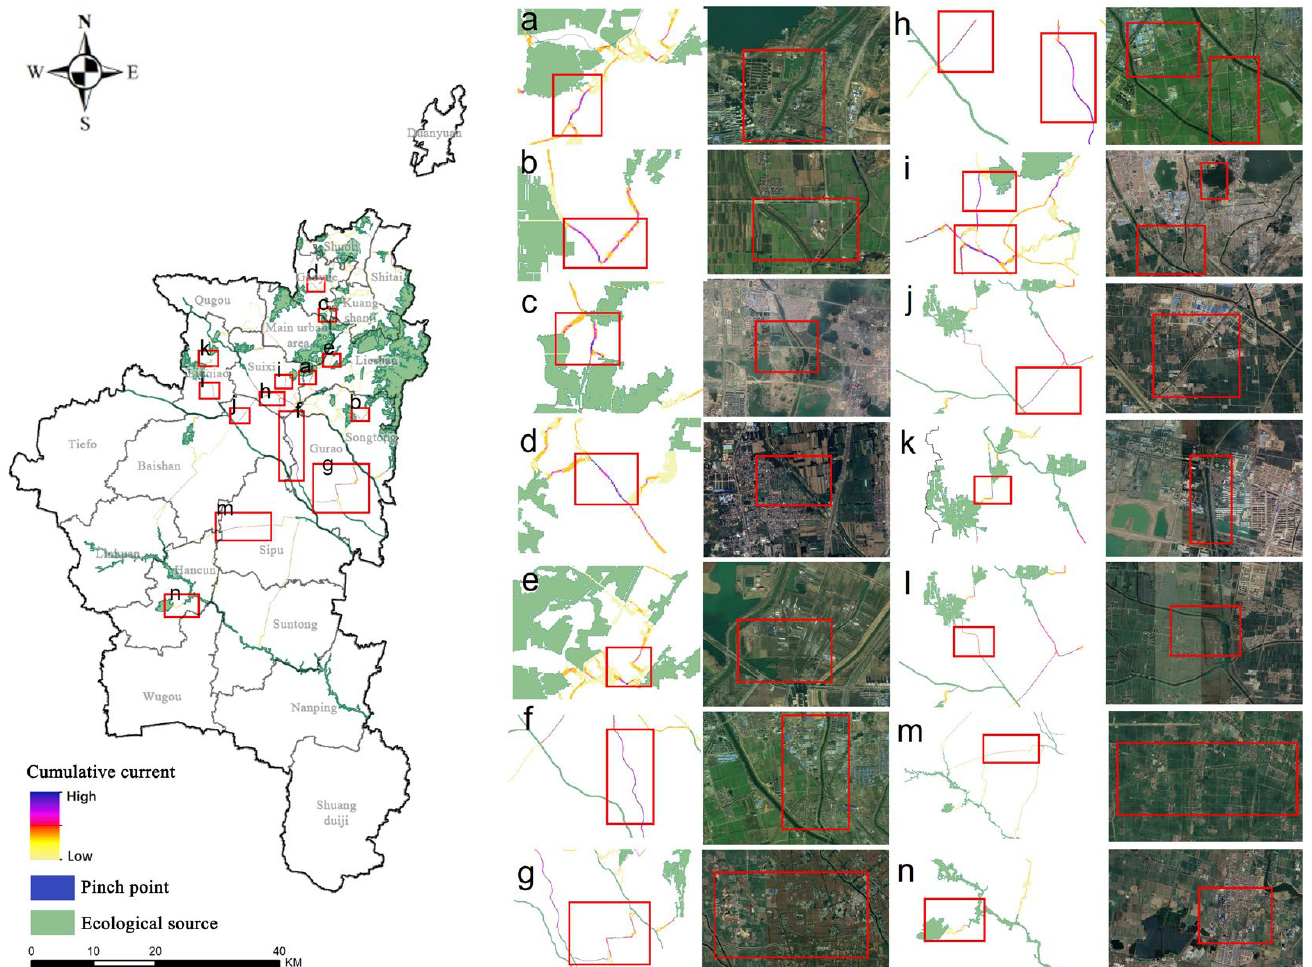
Figure 11. Ecological pinch points in Huaibei City. Red frame shows the exact location of pinch points. Subfigures( a – n ) are subfigures showing a real view of pinch points. Table 4. Distribution of ecological pinch points in Huaibei City.